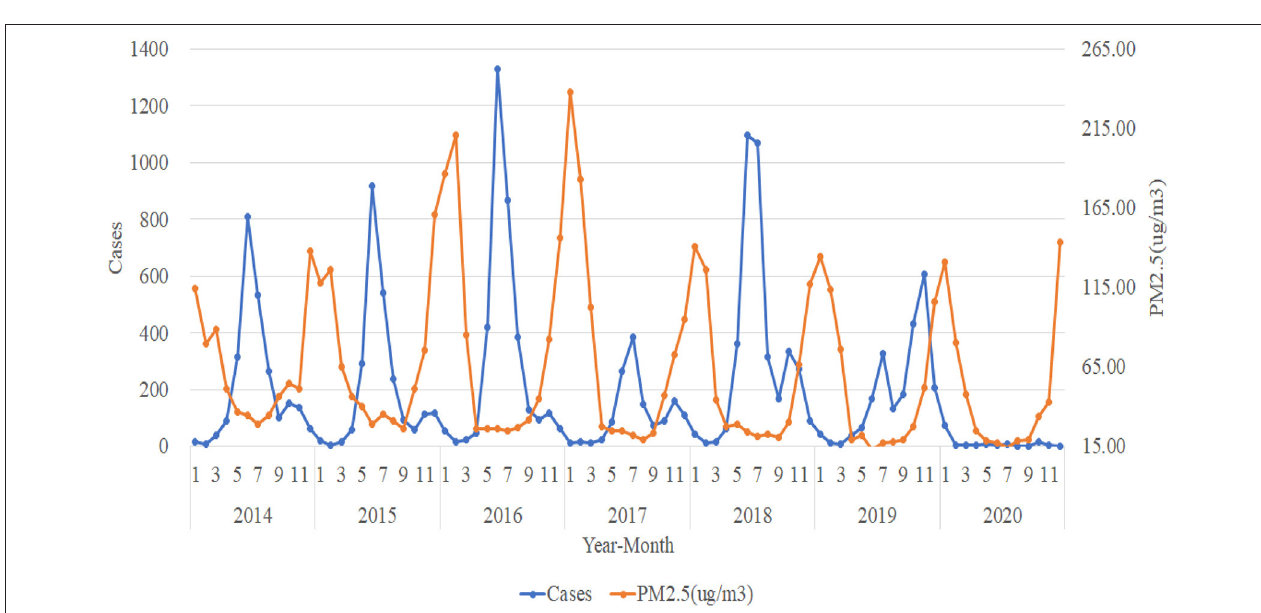
FIGURE 5 | Trends in the number of HFMD cases and PM 2.5 (ug/m 3 ).